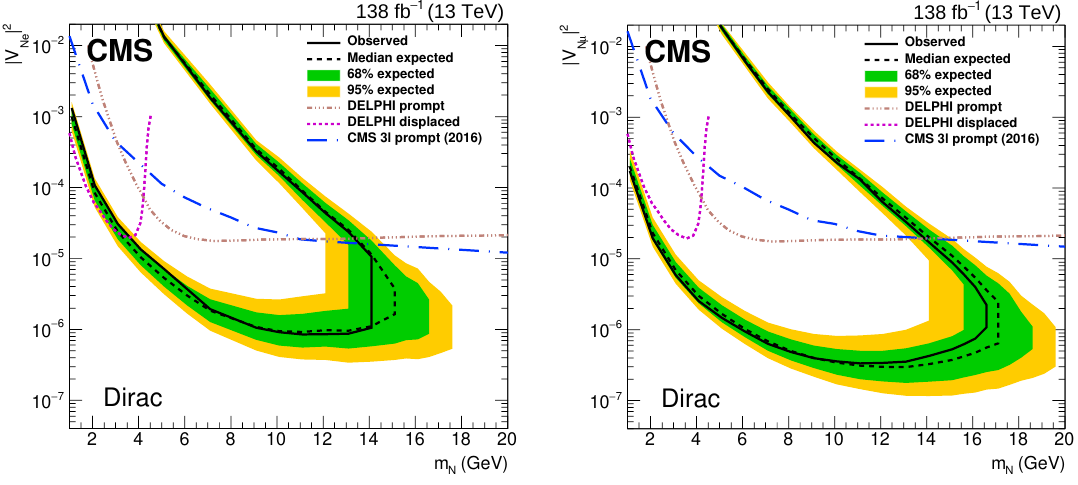
for a Dirac | 2 (left) and | V | 2 (right) as functions of m Ne N m N